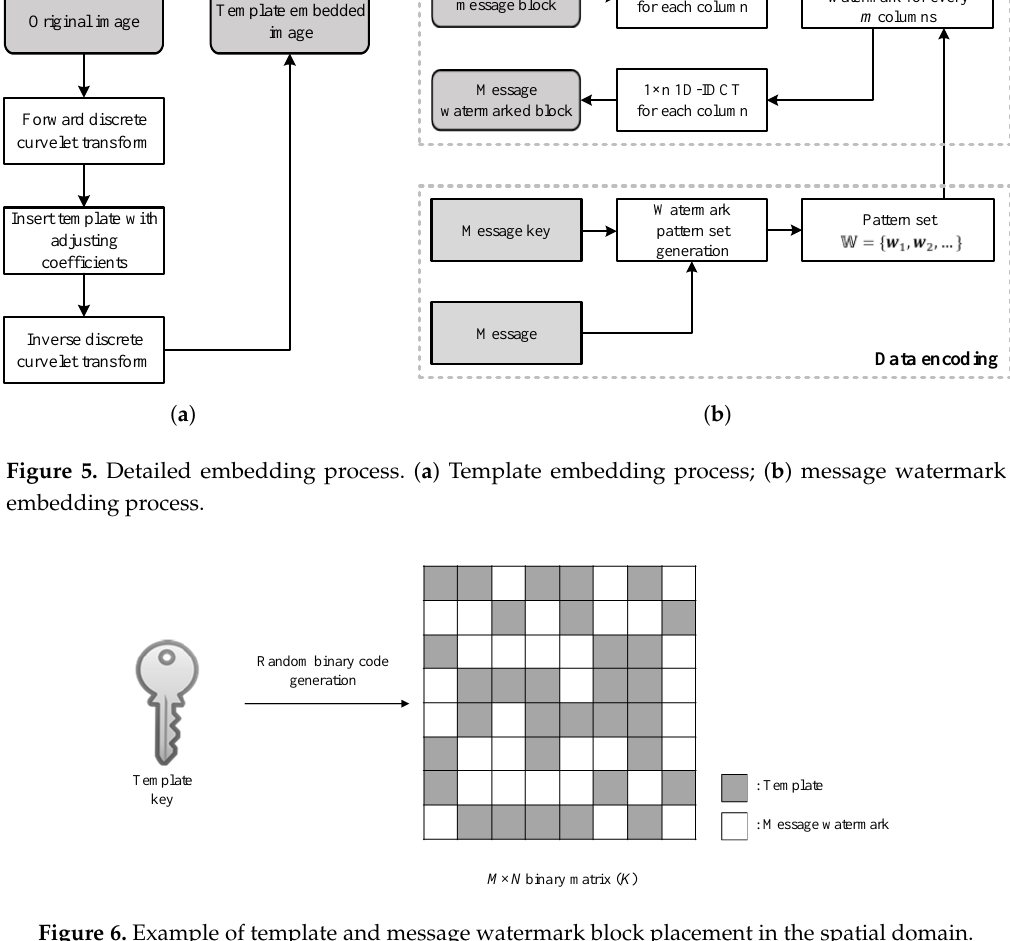
Figure 6. Example of template and message watermark block placement in the spatial